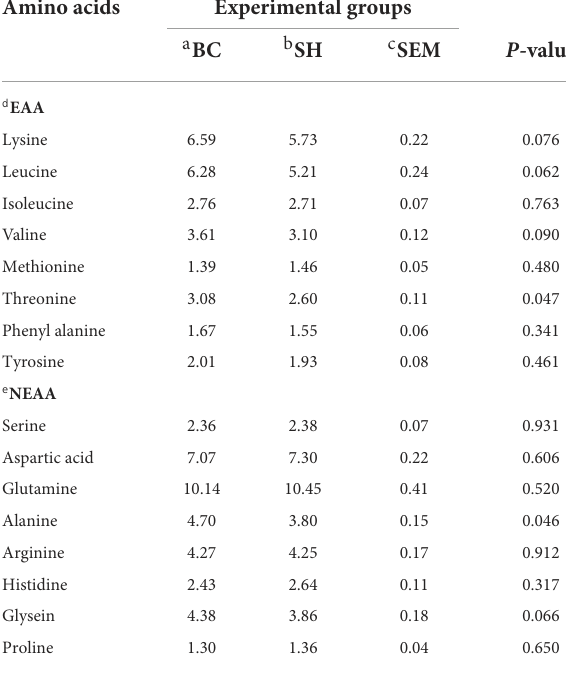
TABLE 5 Amino acids profile (g 100 g − 1 ) of breast muscle in broiler chickens and spent laying hens. Amino acids Experimental groups Amino